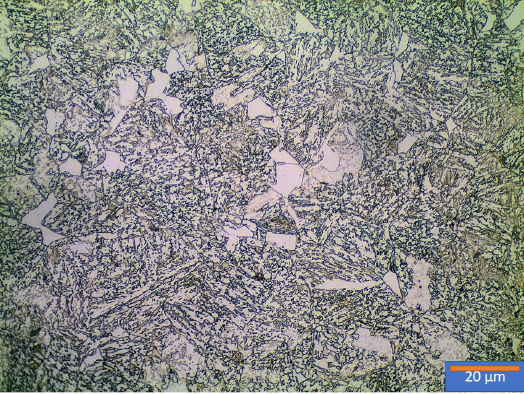
Figure 1. As-received microstructure revealed by optical microscopy of the DIN 18MnCrSiMo6-4.